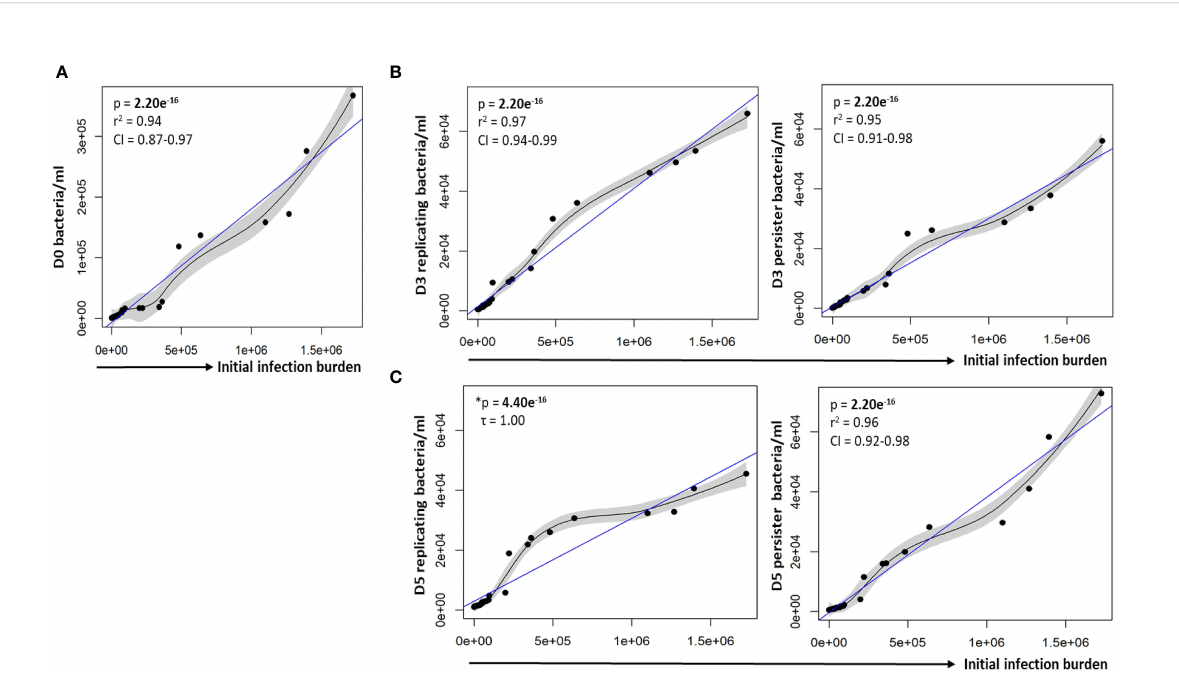
FIGURE 2 Correlation between the infection burden and growth of intracellular bacteria. (A) Macrophages were infected with varying bacterial burdens. Cell enumeration using reference counting beads was used to establish the correlation between the initial infection burden (D0 in vitro bacteria/ml) and intracellular bacteria following uptake. Signi fi cant positive correlations between the initial infection burden and actively replicating bacteria or persisters was observed at (B) day 3 and (C) day 5. Data was assessed using the Pearson ’ s product-moment correlation (linear) and is representative of data independently conducted in 7 biological experiments, including technical triplicates. *The Kendall ’ s Tau correlation was used to determine the non-linear correlation coef fi cient tau ( t ). Signi fi cant p-values (p < 0.05) are shown in bold. The blue line represents the regression line for the correlation analyses (Pearson and Kendall), while the black line and associated shaded area represents the local non-linear regression and 95% con fi dence interval. r 2 , Pearson ’ s correlation coef fi cient squared; CI, 95% con fi dence interval; SEM, standard error of